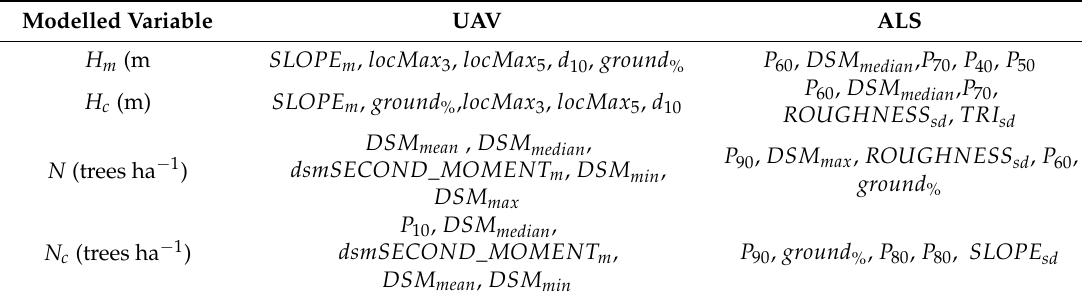
Table 4. Summary of the five most important variables selected by the random forest algorithm for each modelled variable and different remotely sensed data source (i.e., unmanned aerial vehicle, UAV; and airborne laser scanning,